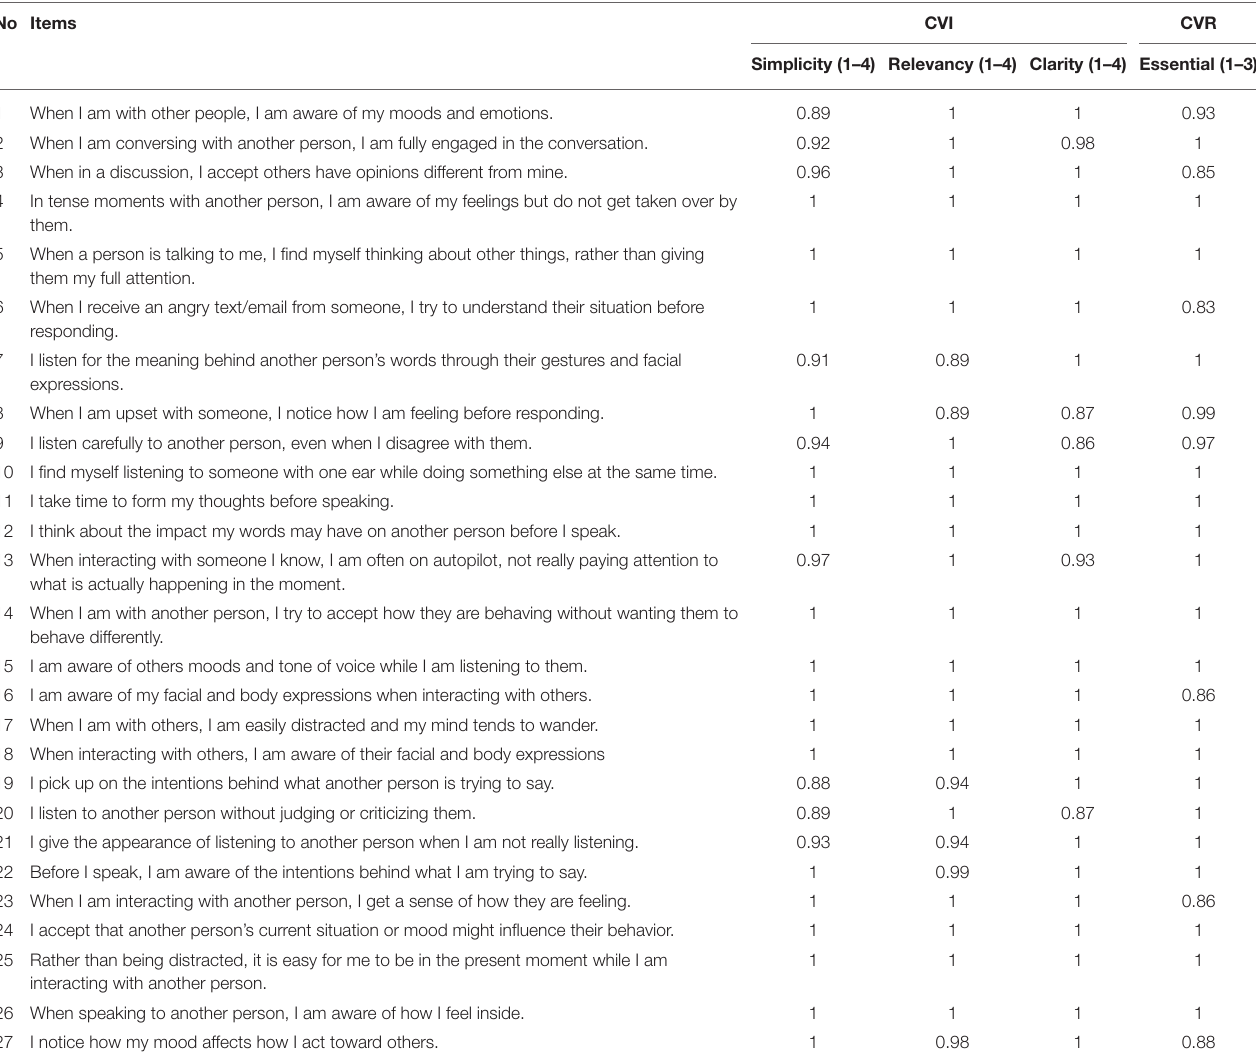
TABLE 1 | CVR and CVI for the items of Interpersonal mindfulness